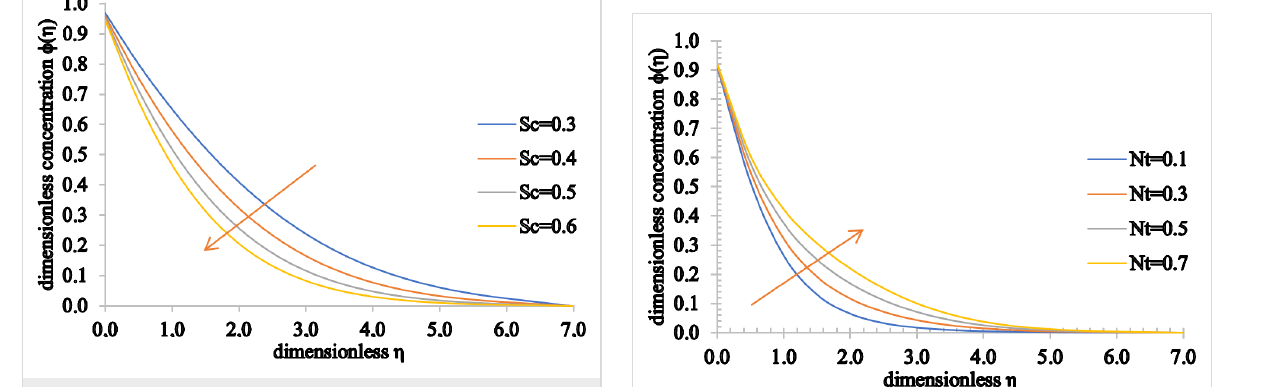
Figure 16: The concentration profile for increasing values of Sc .